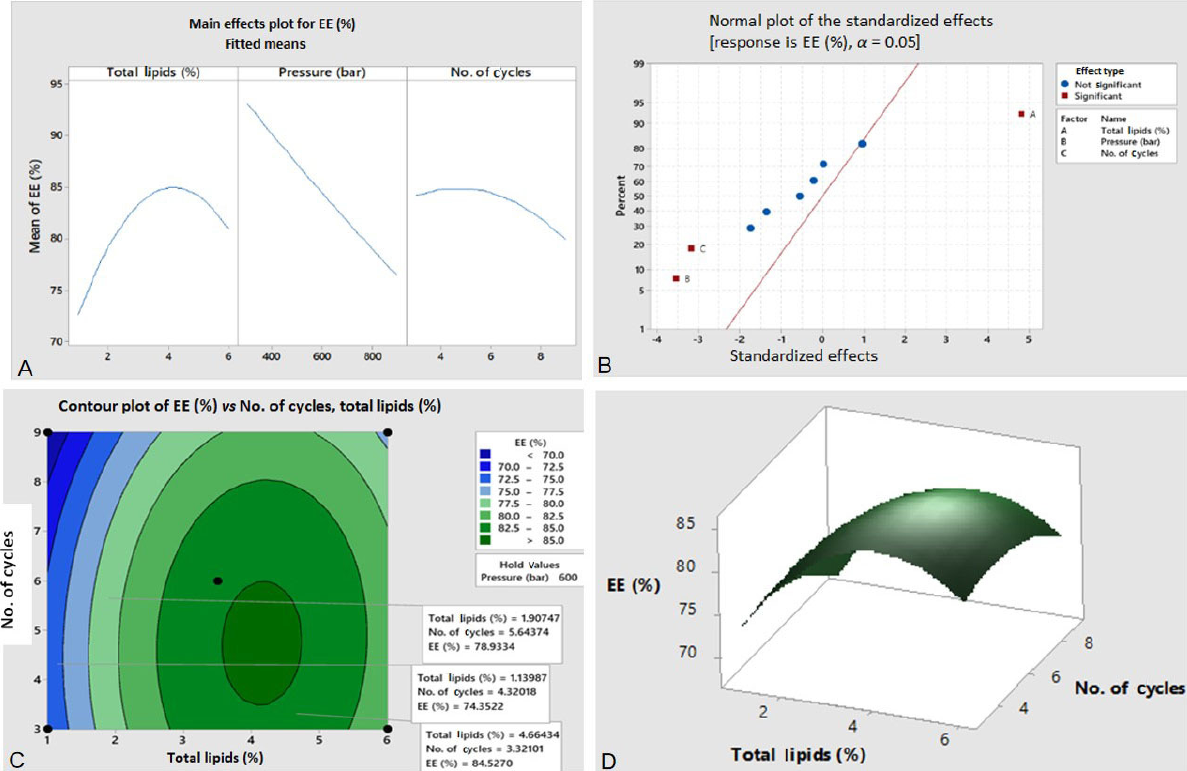
Figure 7. Graphical analysis of EE (%) through (A) factorial plot, (B) normal plot, (C) contour plot, and (D) 3D surface